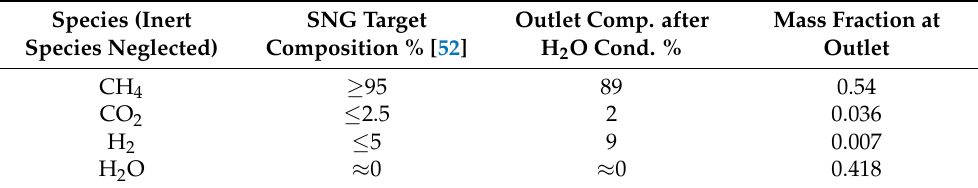
Table 6. Outlet gas composition and SNG quality requirements (1 m reactor